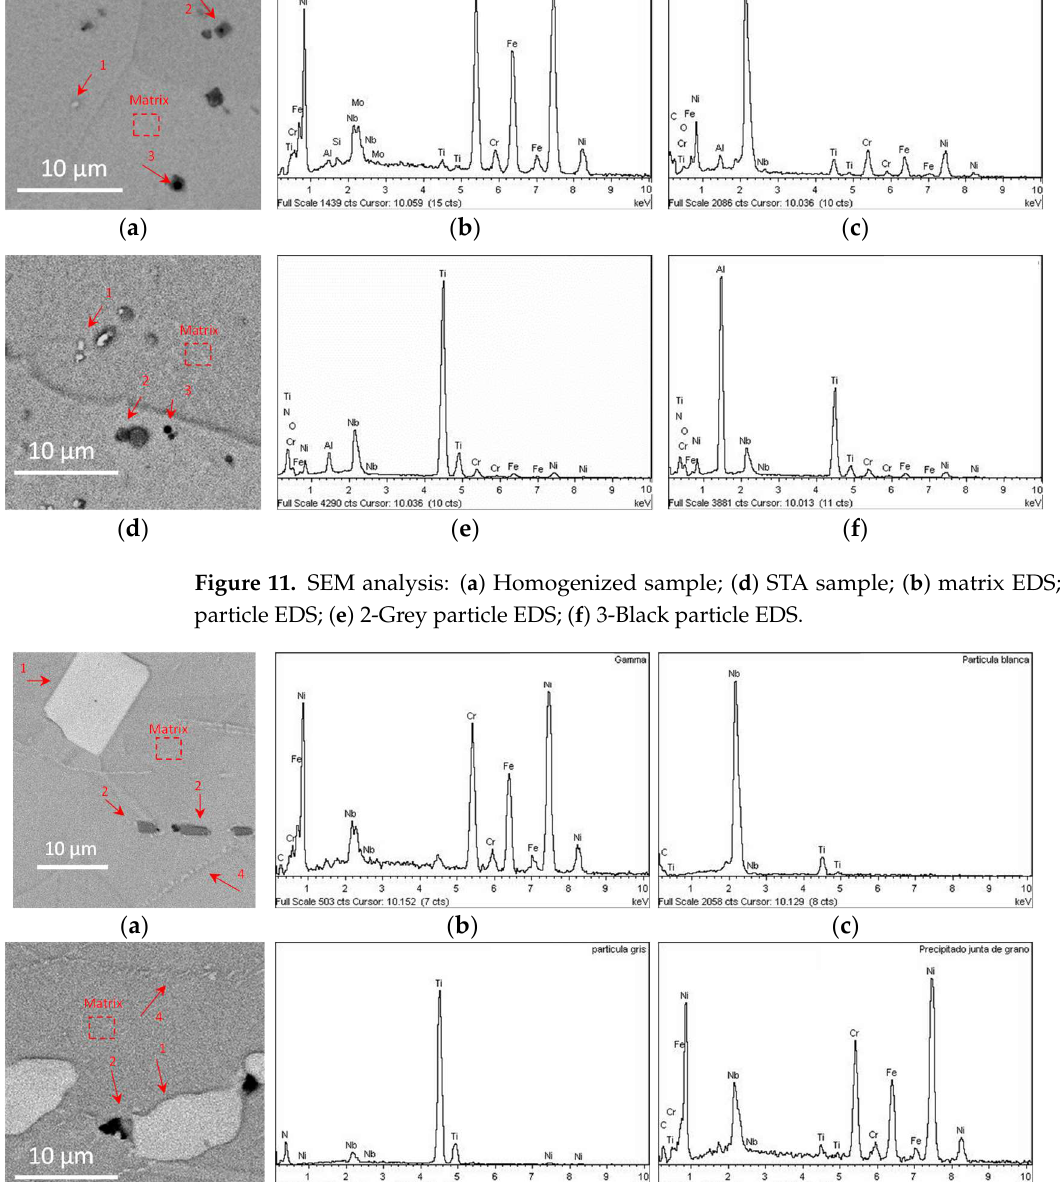
Figure 10. SEM analysis: ( a ) as-deposited sample; ( d ) direct-aged sample; ( b ) matrix EDS; ( c ) 1-white particle EDS (Laves phase); ( e ) 2-Grey particle EDS; ( f ) 3-Black particle EDS. In the homogenized and STA samples, the high temperature of homogenization and solution (at 1100 °C) dissolved most Laves phase (Figure 11a,d). White Nb-rich MC, grey